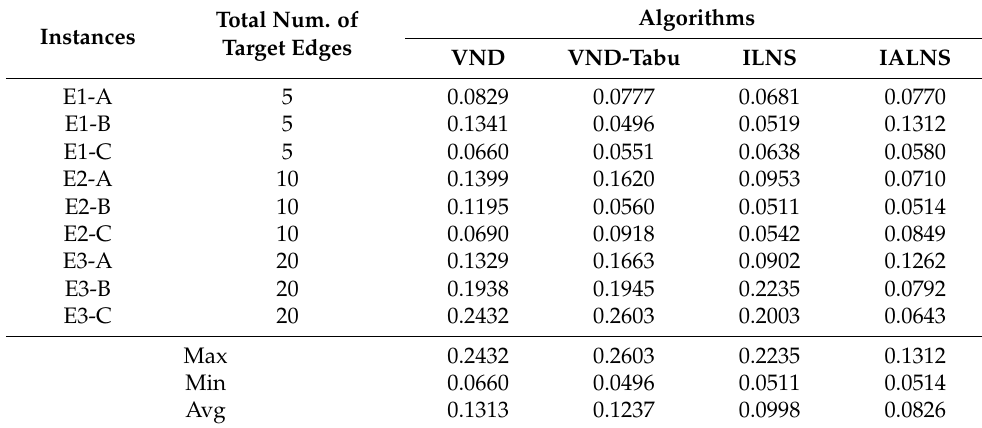
Table 6. The statistical results of the standard deviation of different algorithms. Total Num. of Instances Target